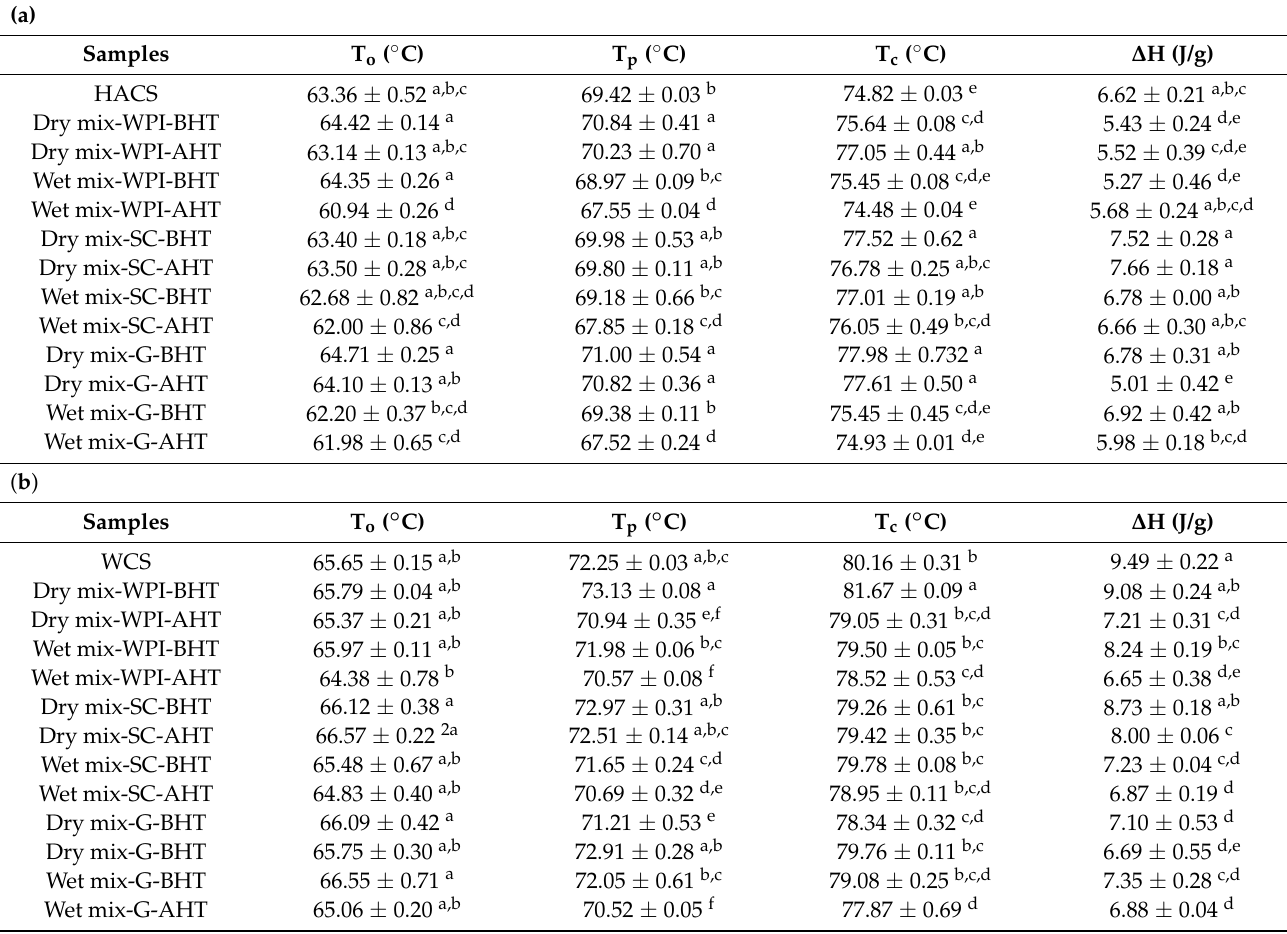
Table 1. ( a ) Thermal properties of corn starch with high amylose (HACS) control and protein- modified HACS before and after DHT. ( b ) Thermal properties of waxy corn starch (WCS) control and protein-modified WCS before and after